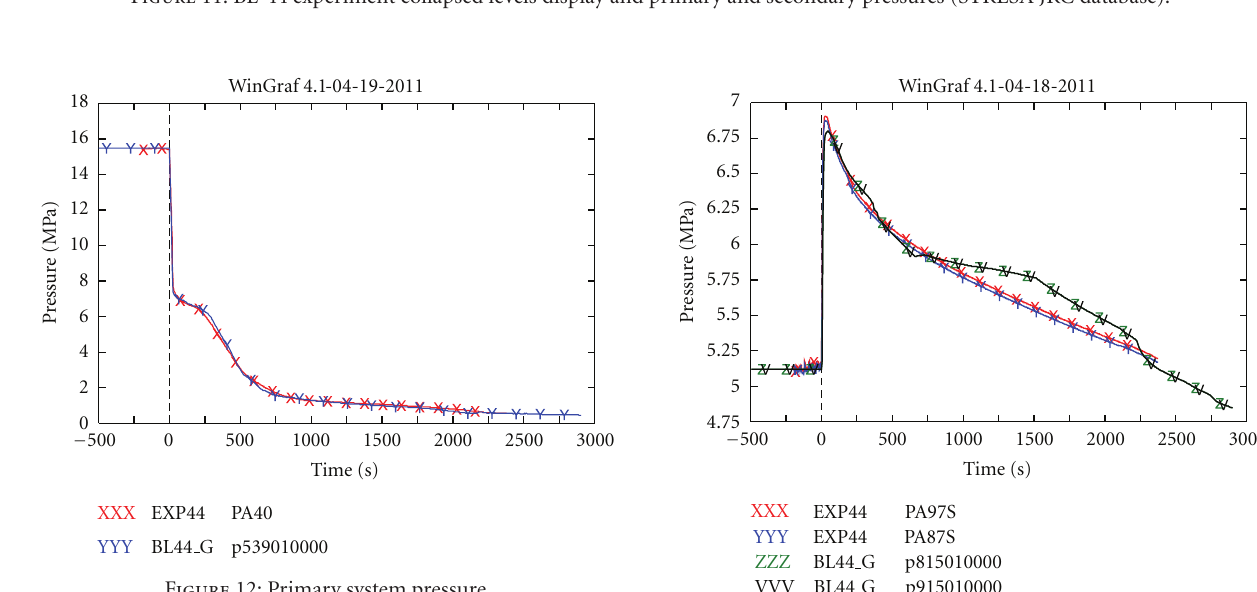
Figure 11: BL-44 experiment collapsed levels display and primary and secondary pressures (STRESA JRC database).